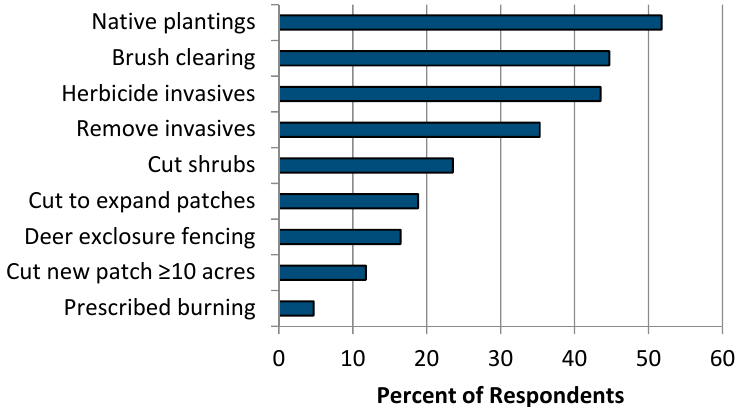
Figure Figure 3. Landowner early successional forest management actions after Natural Resources Conservation Service (NRCS) early successional forest program participation, eastern United States, February–May 2017 (n=85).